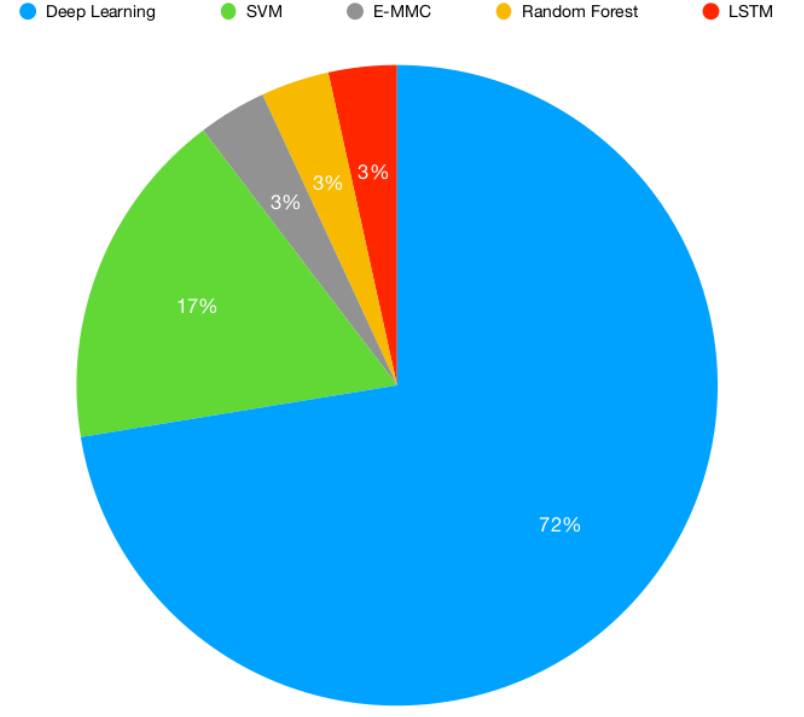
Figure 5. Distribution of machine learning